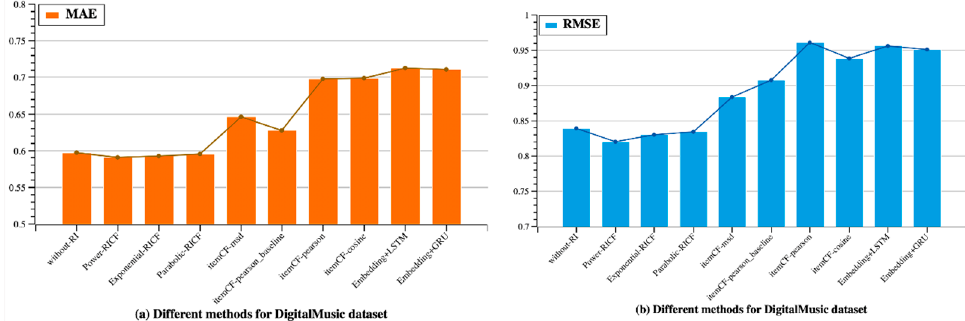
Figure 11. The evaluations of ten algorithms for DigitalMusic dataset. ( a ) MAE metric; ( b ) RMSE metric.